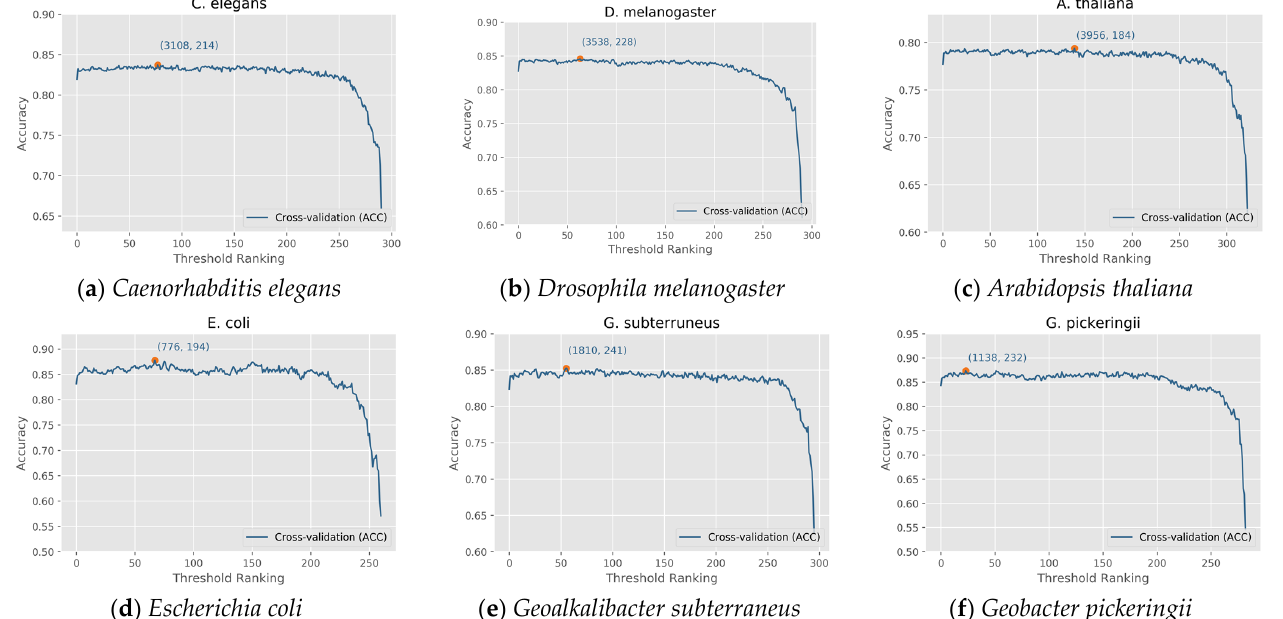
Figure 3. Accuracies of the proposed features on datasets from Caenorhabditis elegans , Drosophila melanogaster , Arabidopsis thaliana , Escherichia coli , Geoalkalibacter subterraneus , and Geobacter pickeringii as the number of selected features increases.